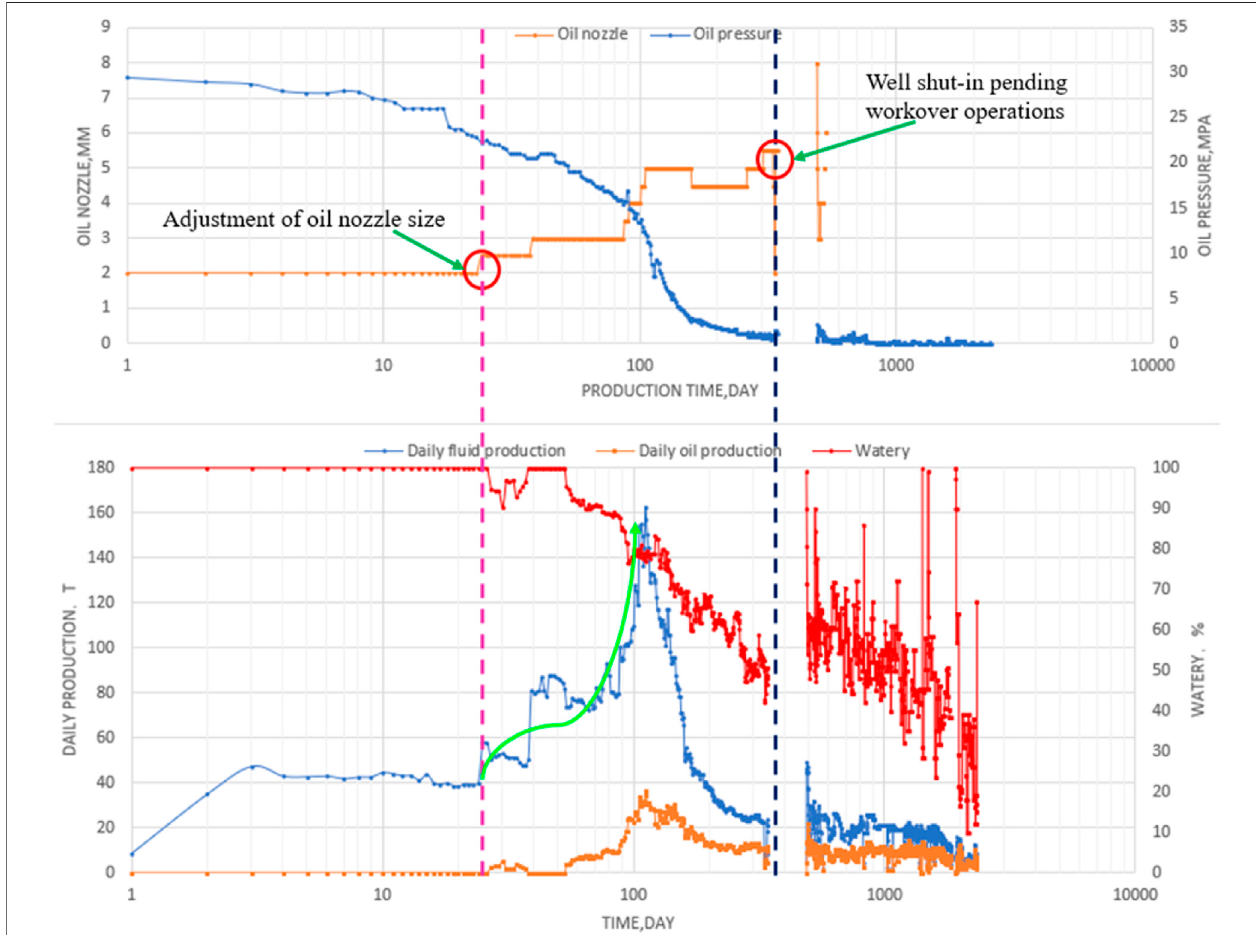
FIGURE 2 | Production curve and nozzle oil pressure variation curve for Well